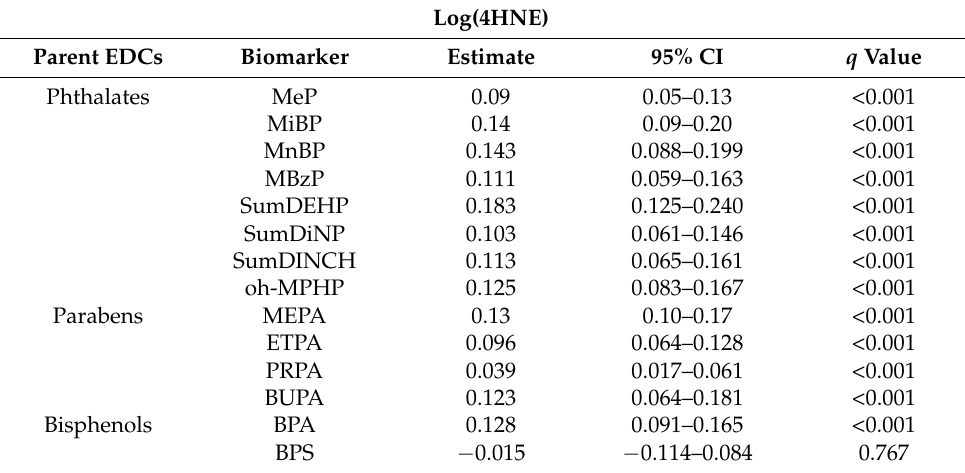
Table 3. Mixed-effect models for the association between the SG-adjusted and logarithm trans- formed biomarkers of exposure to EDCs and the biomarker of effect (4HNE).